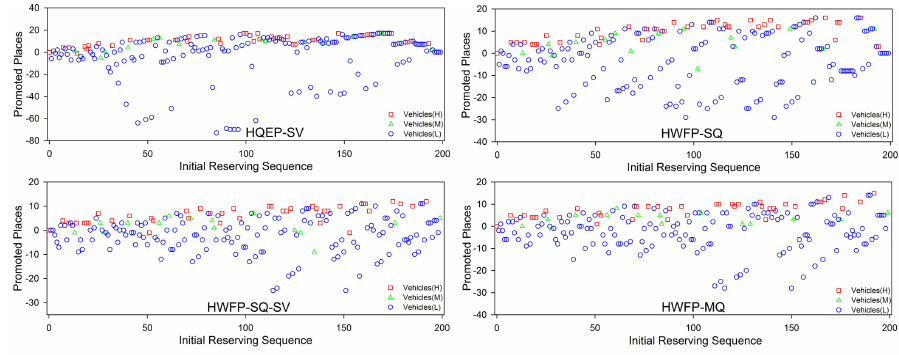
Figure 11. Comparison of Passing-through Orders of Four FAFP-based Policies: λ = 0.15, p υ . l = 4.5 m = 30%, p H = 20%, p M = 10%, p L = 70%, d a = 8 m, d r = 30 m, v m = 10 m/s, v r = 6 m/s, v γ = 8 m/s, N = 2.